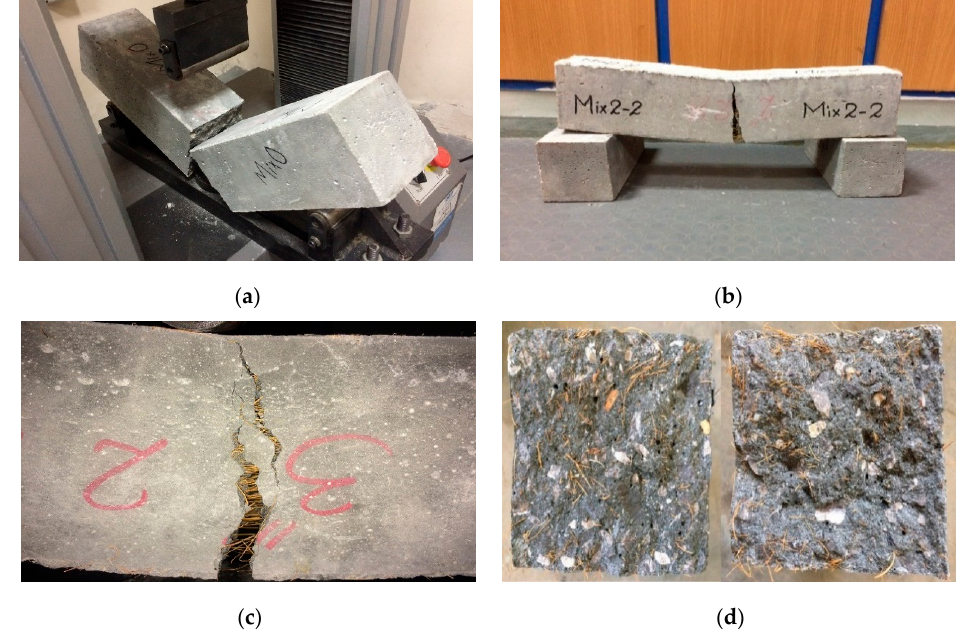
Figure 11. Beams test: ( a ) Tested HSC beam; ( b ) Tested CFR-HSC beam; ( c ) Fiber bridging in beam; ( d ) Cross-section of tested CFR-HSC beam.